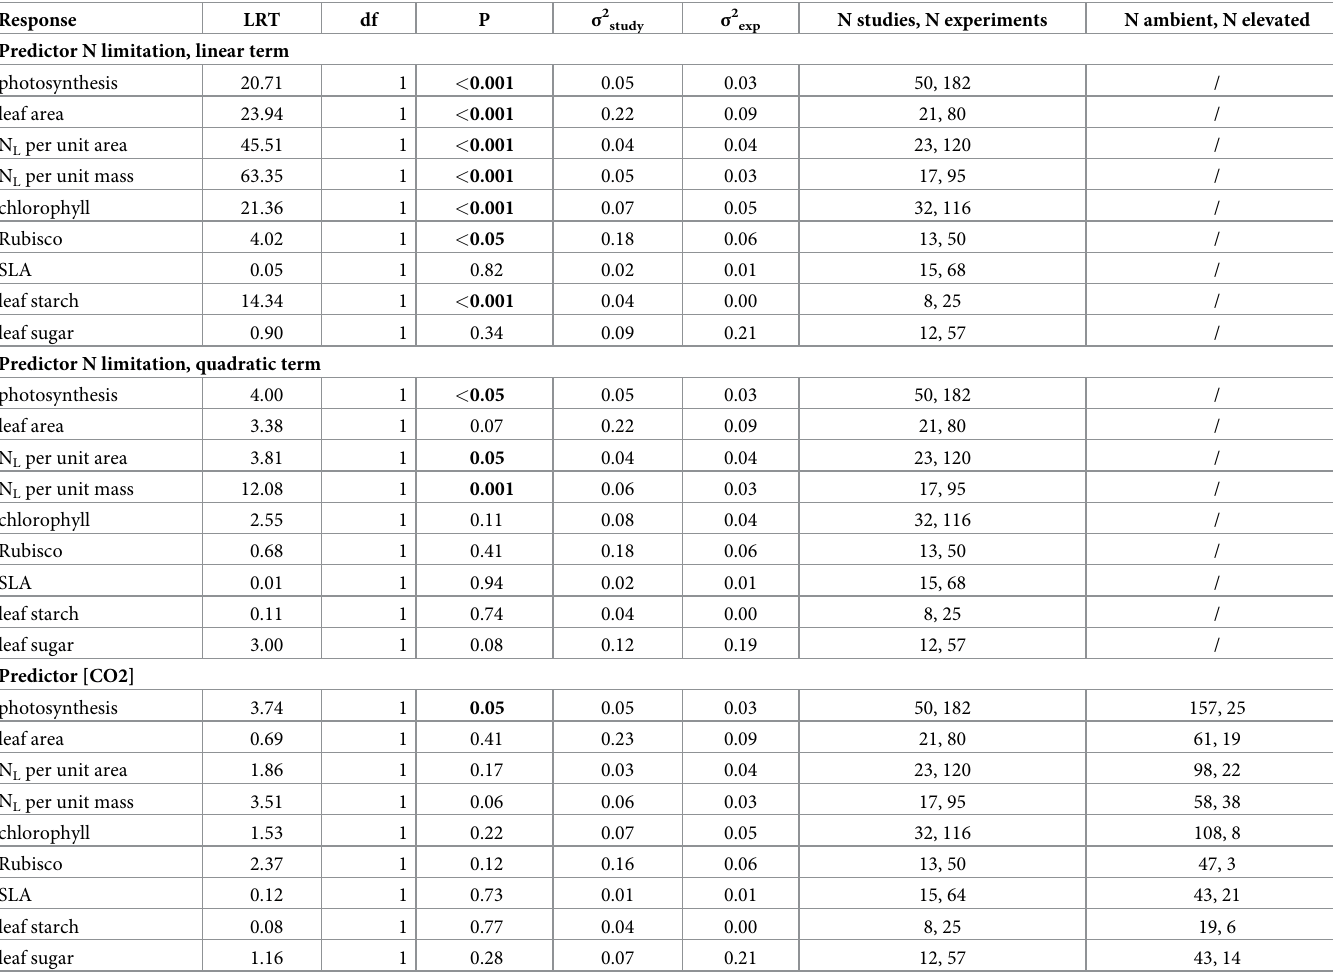
Table 3. Results of the linear mixed models for all response variables with N limitation (linear or quadratic term) or CO 2 level (ambient vs. elevated) as